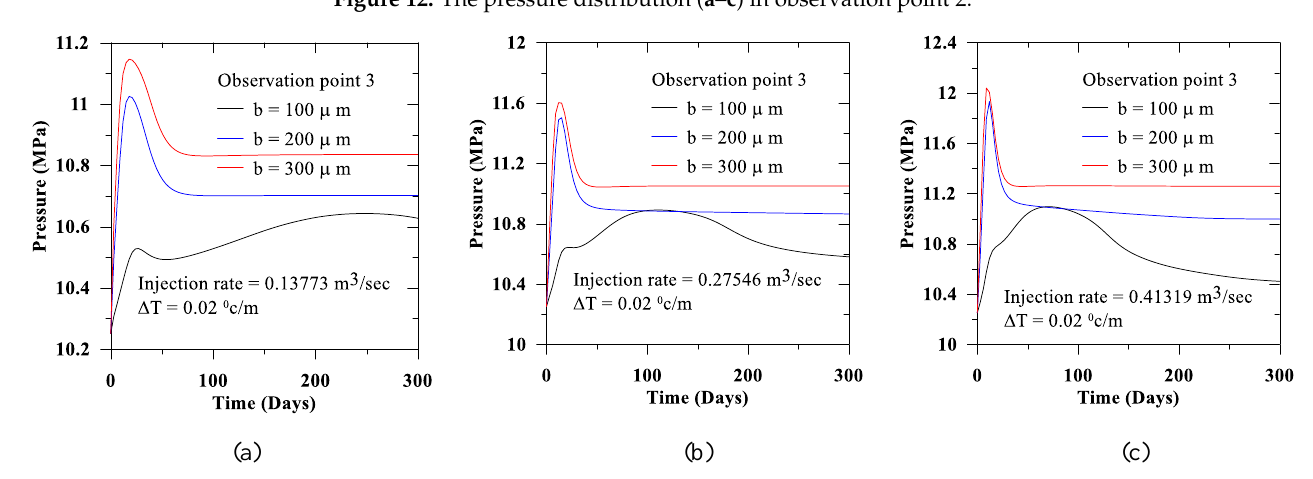
Figure 13. The pressure distribution ( a – c ) in observation point 3.